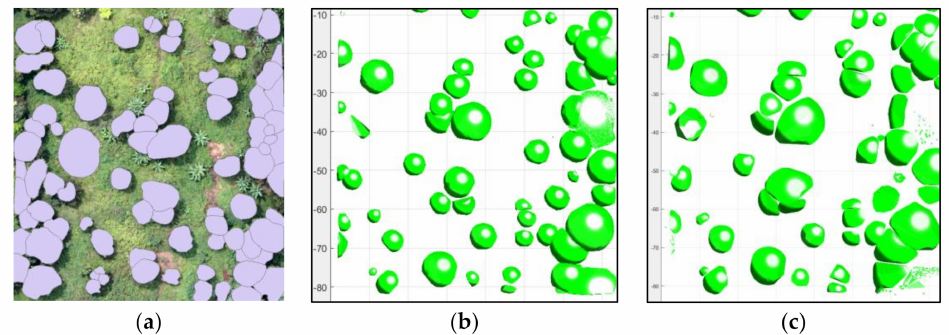
Figure 19. Comparison between ( a ) manual tree digitization results with ( b ) top view of modeling with LiDAR data and ( c ) top view of modeling with photogrammetric